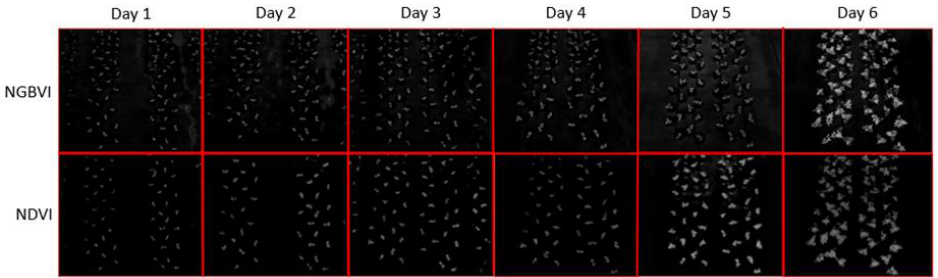
Figure 1. Block diagram for the overall quantification algorithm.